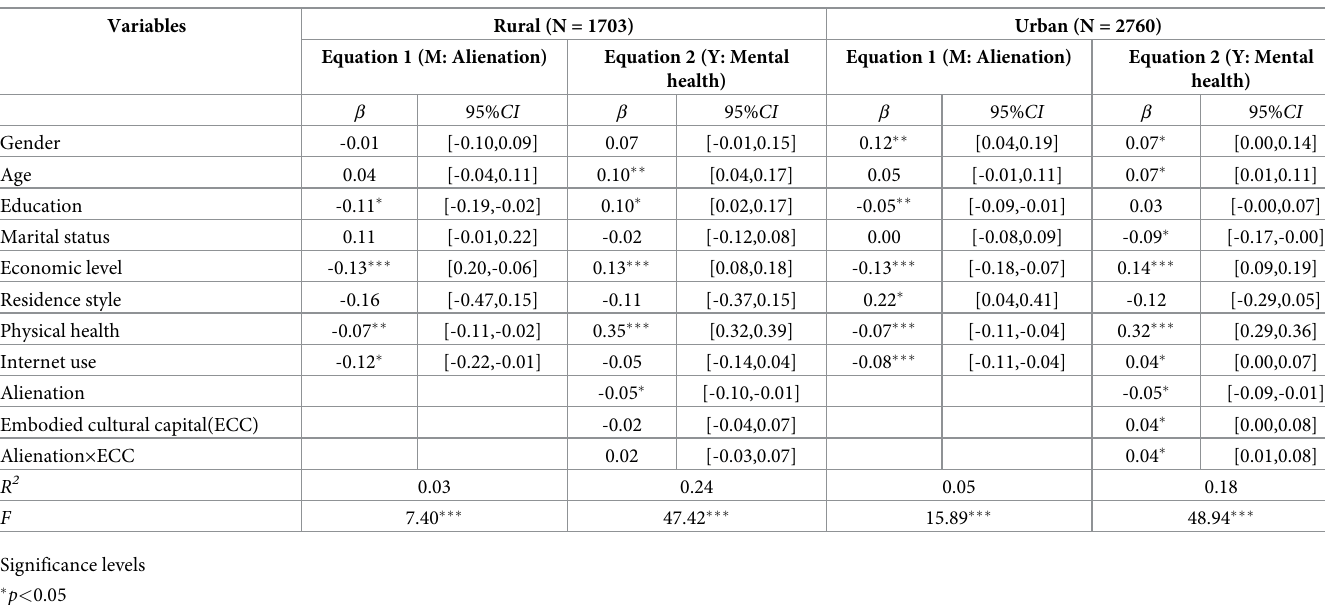
Table 8. Moderated mediation effect of Internet use on mental health of urban and rural elderly.